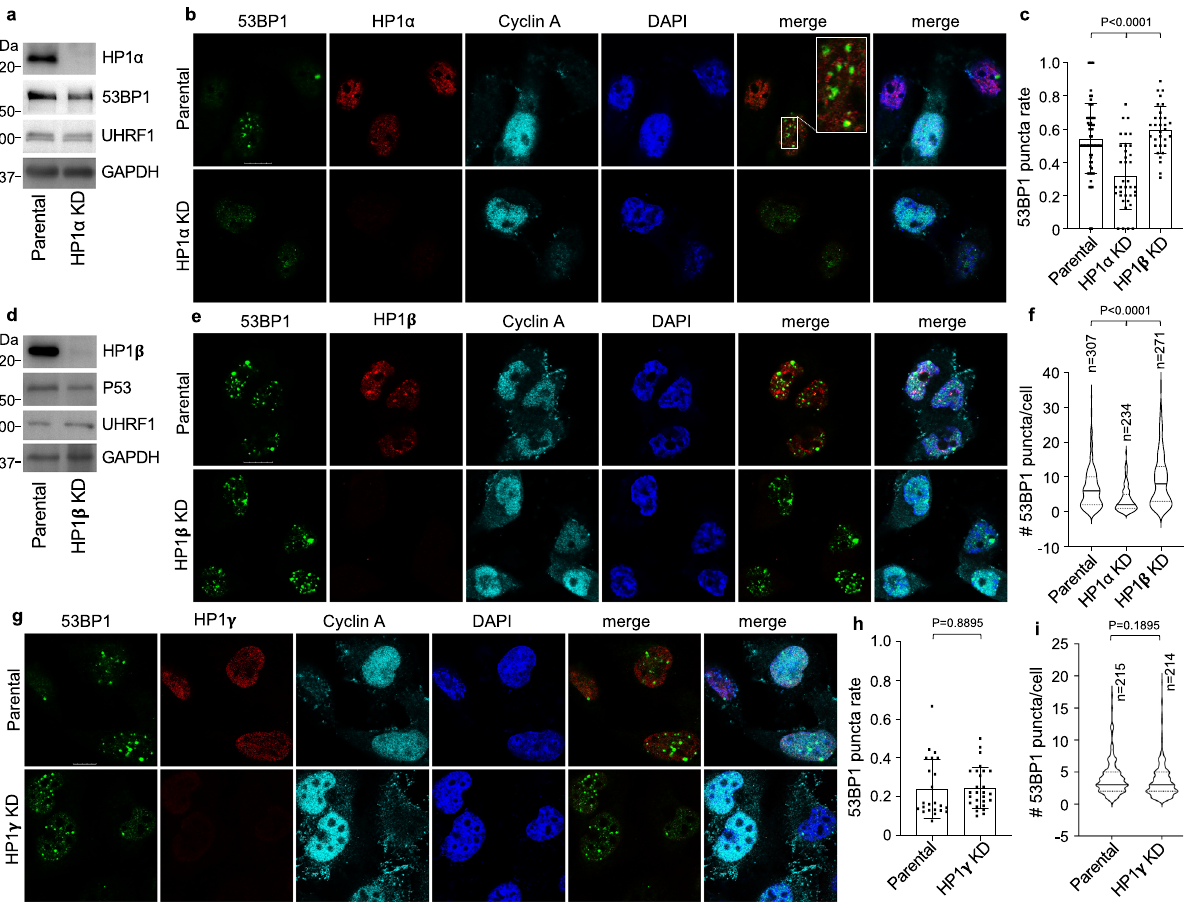
Fig. 3 53BP1 puncta depend on heterochromatin. MDA-MB-231 cells were stably depleted of HP1 α ( a ) or HP1 β ( d ), and protein expression was analyzed. Representative single z-plane confocal images of parental and HP1 α ( b ), HP1 β ( e ) or HP1 γ ( g ) KD MDA-MB-231 cells. Quantitation of 53BP1 puncta rate ( c , h ) or number ( f , i ) from three independent experiments was shown. Violin plots of 53BP1 puncta number ( f , i ) represent mean, 25th, and 75th percentile from indicated number of cells. The whiskers extend to the minimum and maximum values. In c , n = 60, 37, and 31 images were analyzed for n = 309, 252 and 274 parental, HP1 α KD and HP1 β KD cells, respectively. In h , n = 23 and 27 images were analyzed from a total of n = 215 and 214 parental and HP1 γ KD cells, respectively. Scale bar in all images is 10 μ m. Data represent mean values and SD in ( c ) and ( h ). Unpaired two-tailed t test using Prism 9.0 was performed for c , f , h , and i with 95% con fi dence